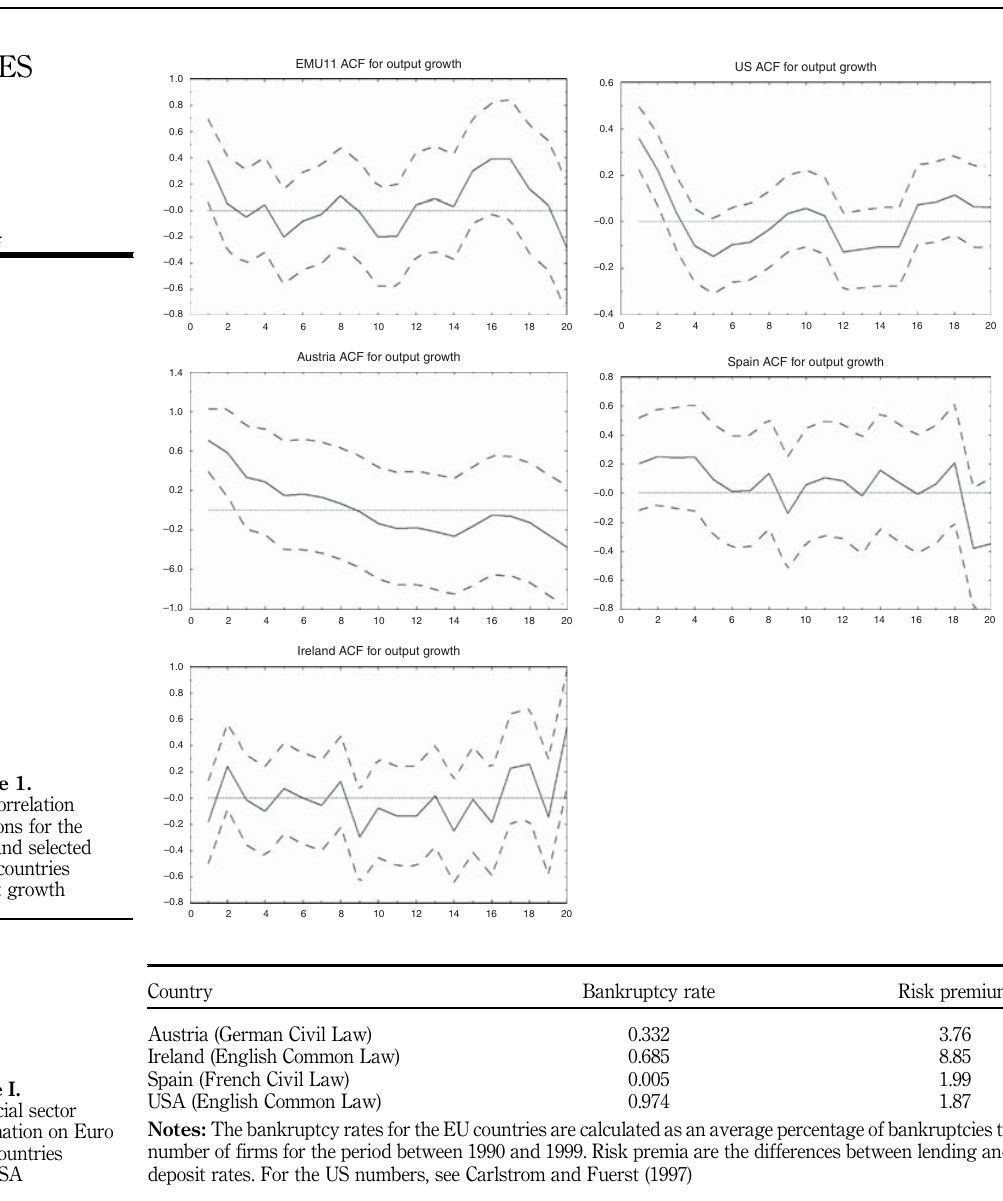
Figure 1. Autocorrelation functions for the USA and selected EMU countries output growth